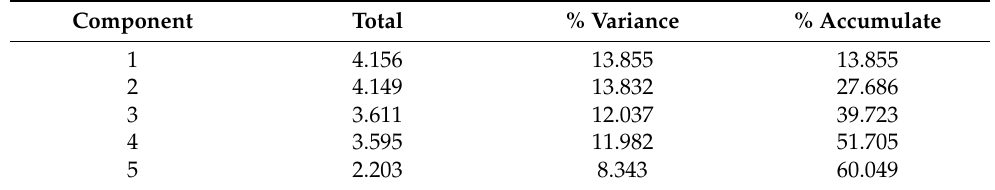
Table 3. Total variance explained by the five dimensions of the Spanish version of the Sexual Satisfaction Scale for Women (SSS-W-E). Rotation sum of charges